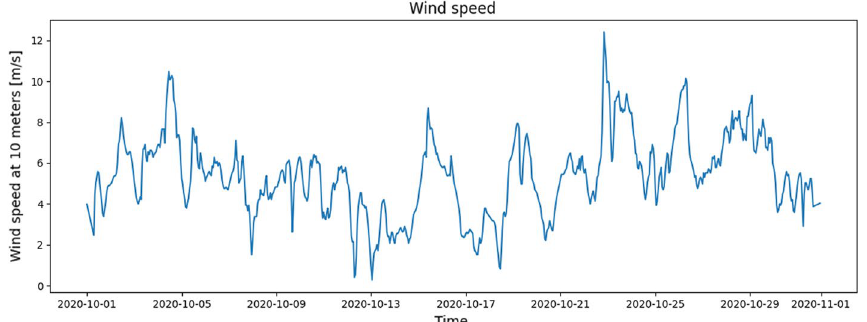
Fig. 18 The wind speeds in October 2020, Esbjerg,